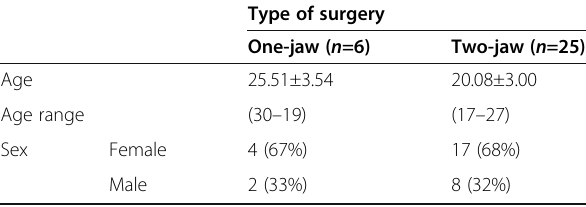
Table 1 Descriptive statistics for demographic variables according to the type of surgery (one-jaw and two-jaw surgery)